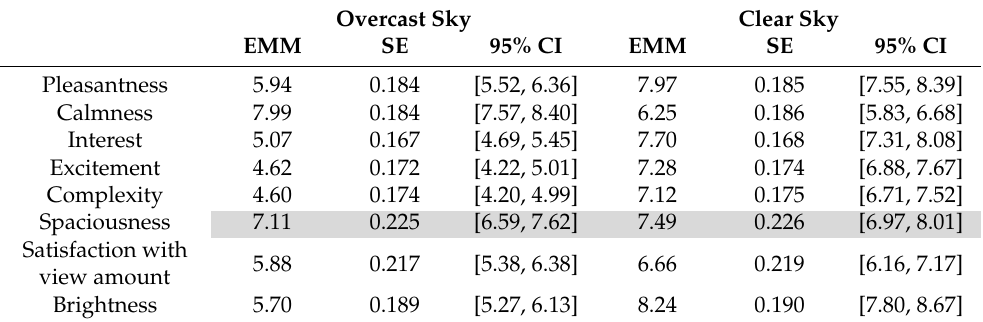
Table 7. Results of the LMM analysis for the main factors of aperture design, window size and sky type on EEG predictors. EEG Predictors